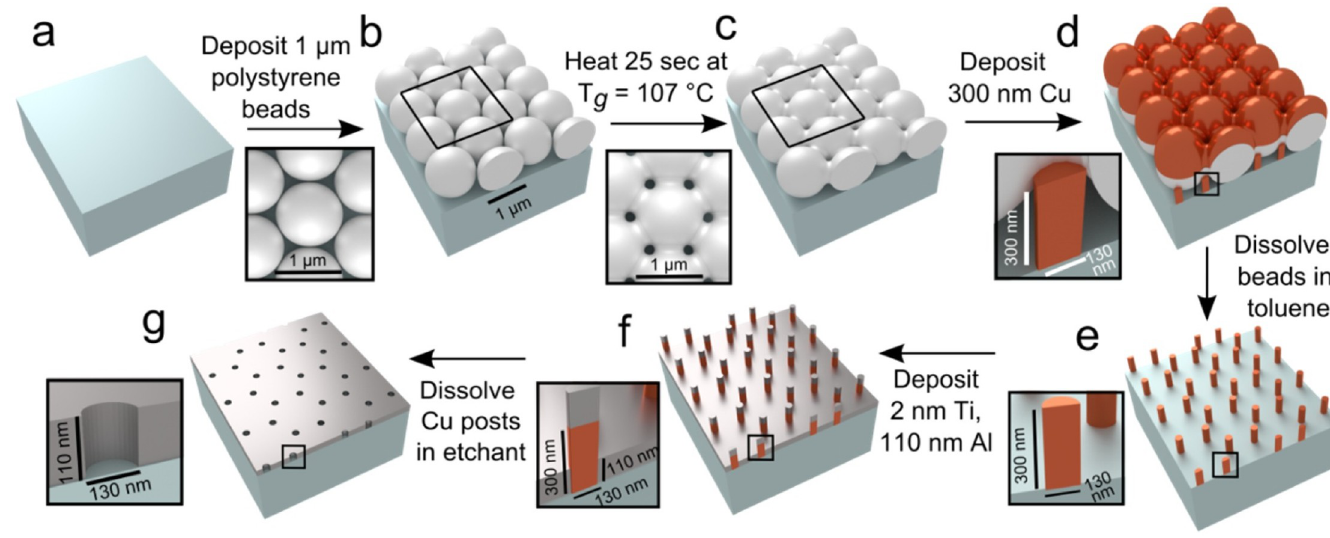
Fig 1. Schematic of aluminum ZMW fabrication. The starting material is a glass microscope coverslip. Steps in fabrication and listed and explained in the main text. Black boxes represent expanded insets. T g is the glass transition temperature of the polystyrene